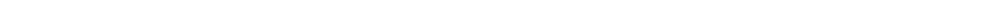
(see fi gure on previous page) Fig. 7 BTK-KO CD4 + T cells are more prone to Th1 differentiation. A Btk mRNA expression in the indicated cell subsets from WT mice analyzed by quantitative RT-PCR. SPL: spleen. MLN: mesenteric lymph node. LP: lamina propria. GAPDH served as the internal control. B Btk mRNA expression in naïve and in vitro differentiated CD4 + T cell subsets analyzed by quantitative RT-PCR. Ubiquitin C served as the internal control. C , E Intracellular IFN- γ expression by WT and BTK-KO CD4 + T cells differentiated under Th0 ( C ) and Th1 ( E ) conditions for 4 days. Numbers shown are percentage of cells in the indicated gates. D , F Quanti fi cation of IFN- γ secretion from CD4 + T cells differentiated under Th0 ( D ) and Th1 ( F ) conditions by ELISA using known standards. G Intracellular Foxp3 expression by WT and BTK-KO CD4 + T cells differentiated under the Treg condition for 3 days. Numbers shown are percentage of cells in the indicated gates. Data are presented as mean ± SD ( n = 3 – 5). Statistical signi fi cance in B was determined by one- way ANOVA with Tukey ’ s multiple comparisons test. Statistical signi fi cance in C – G was determined by two-sided independent sample Student ’ s t - test. ns: not signi fi cant; * P < 0.05, ** P < 0.01 and *** P <